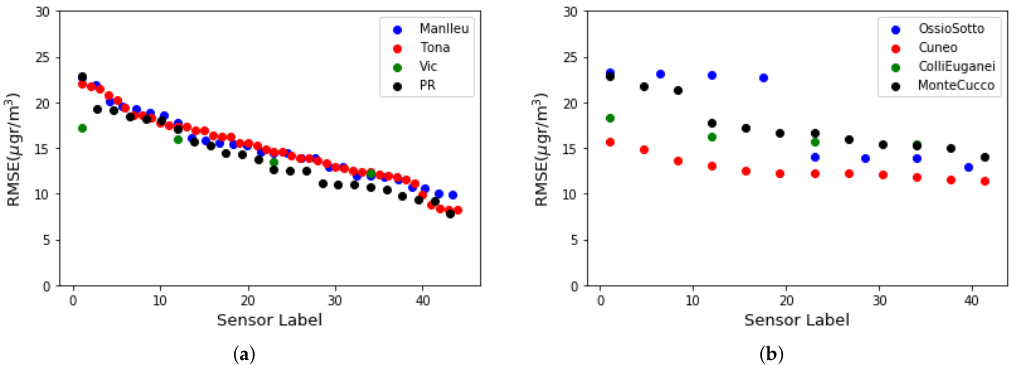
Figure 3. RMSE classified for testbed and place: ( a ) Spanish Testbed, ( b ) Italian